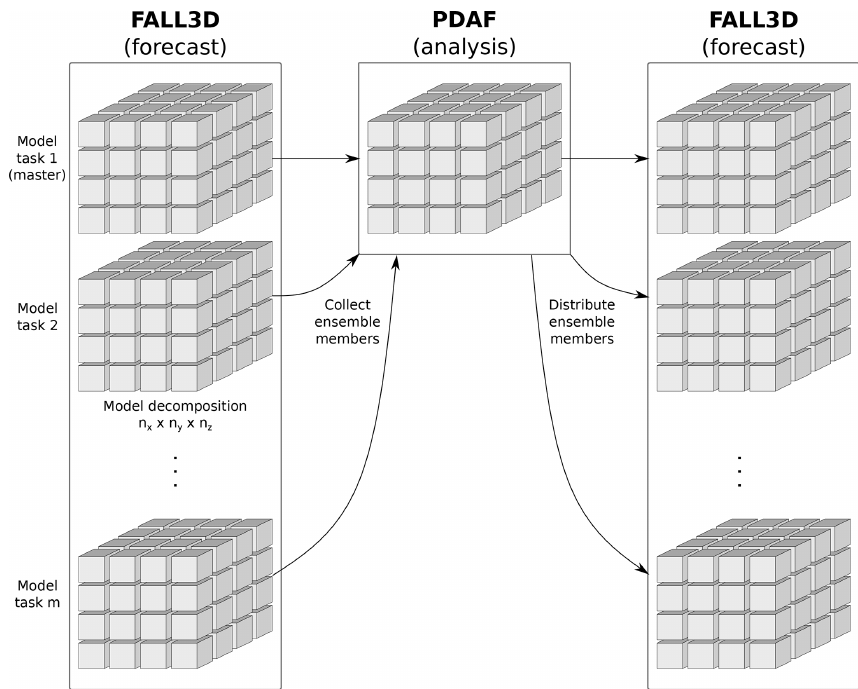
Figure 2. Scheme of the ensemble-based data assimilation system implemented in the FALL3D dispersal model. The system builds upon an efficient implementation by coupling FALL3D and the Parallel Data Assimilation Framework (PDAF) and uses a two-level parallelisation scheme based on MPI (message passing